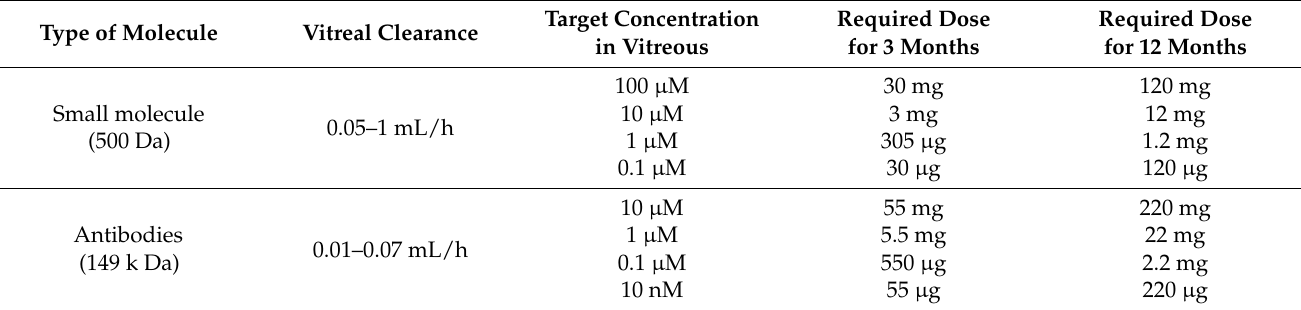
Table 3. Relationship between drug dose and dosing frequency for drugs with different target concentrations from pharmacokinetic simulations